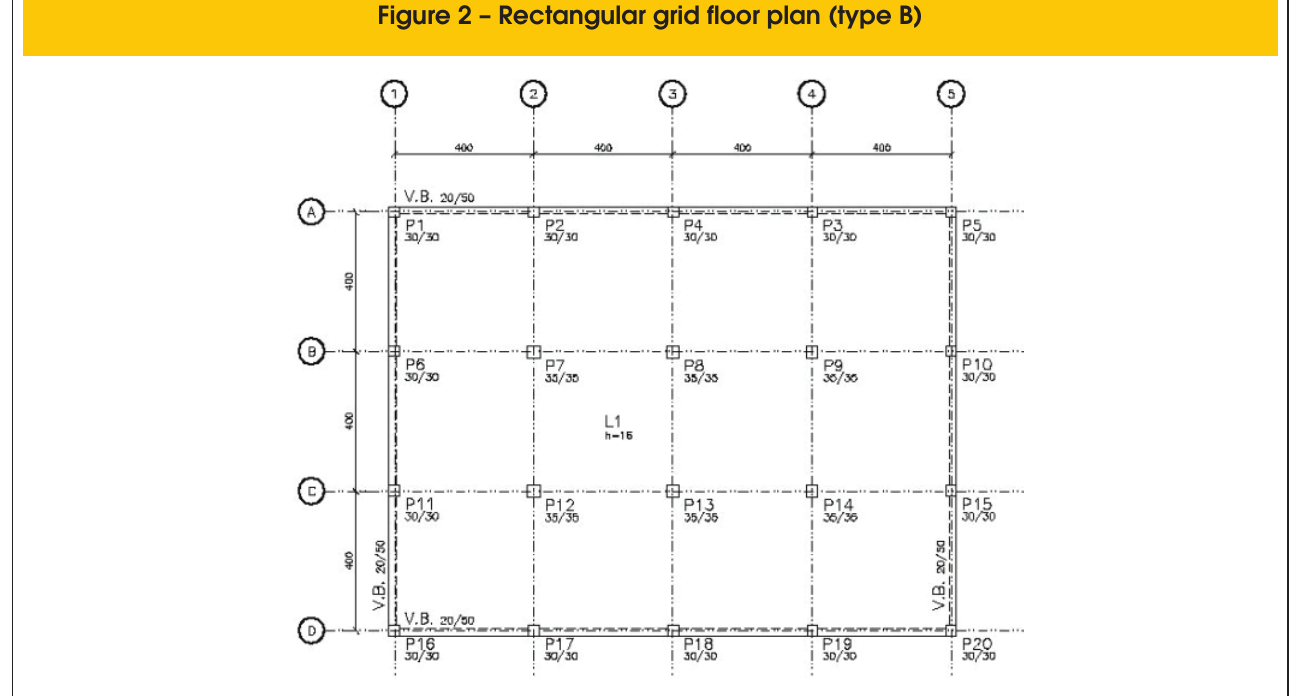
Figure 2 – Rectangular grid floor plan (type B)